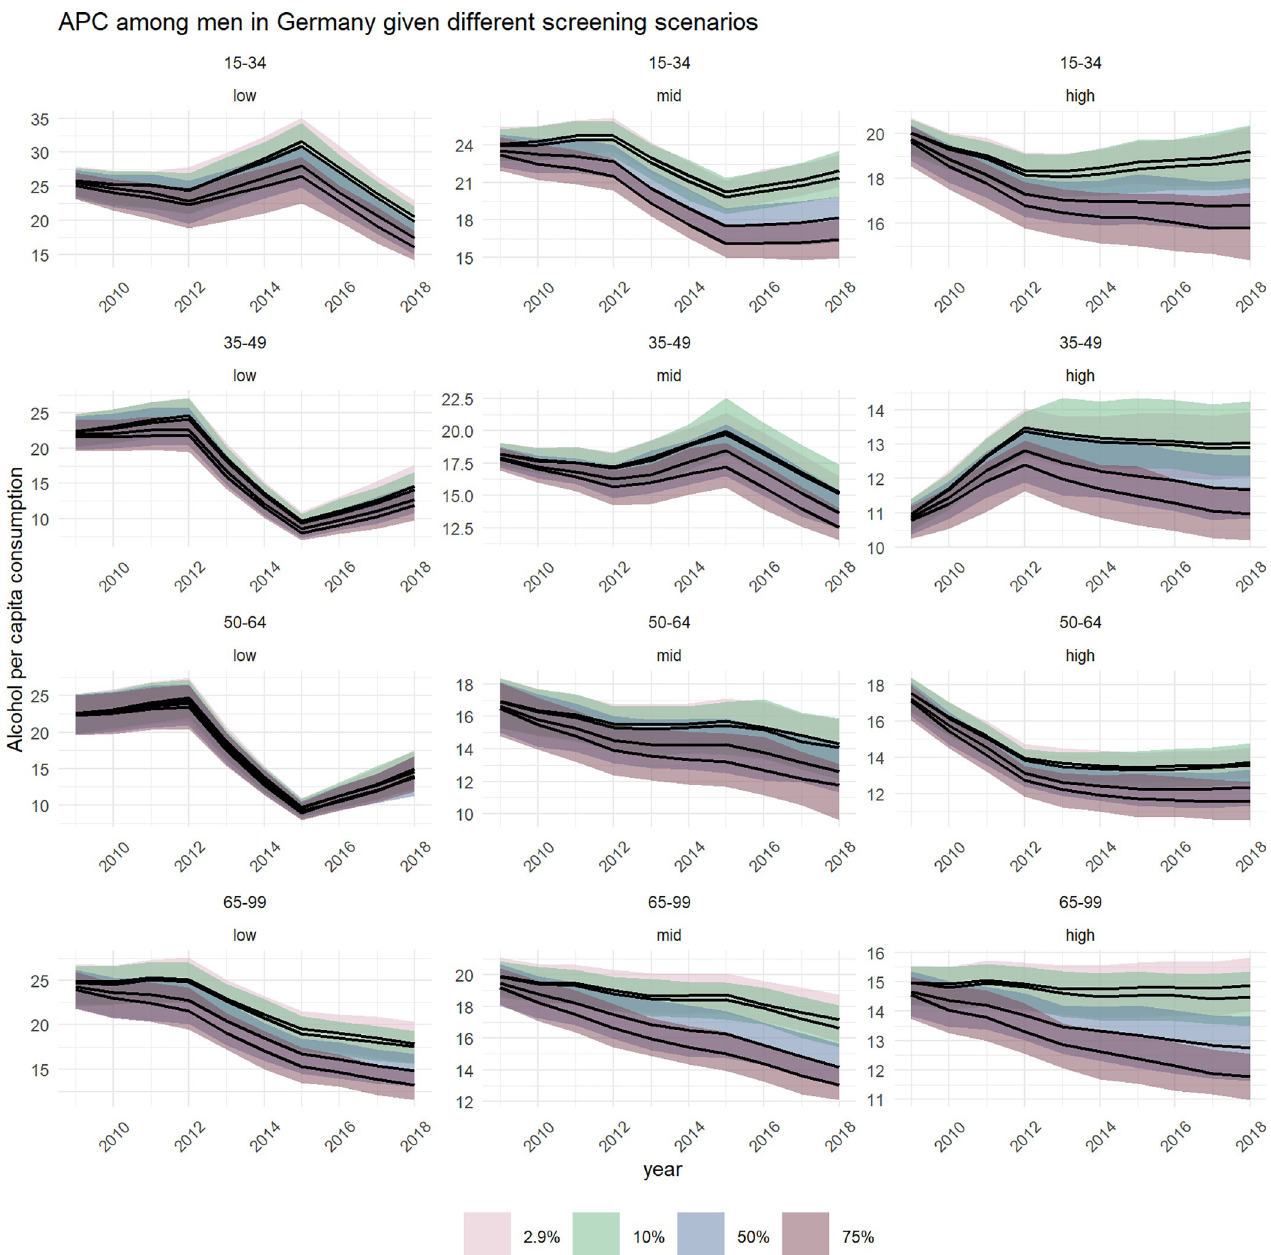
Fig 5. Trends of alcohol per capita consumption (in litres pure alcohol) among German men between 2009 and 2018, stratified by age (horizontal) and education status (vertical), by annual screening coverage (coloured shade). In each facet, the upper line represents the baseline scenario with a screening rate of 2.9%. The increasing coverage rate is represented by all lower lines with the second highest representing 10%, the third highest representing 50%, and the lowest representing 75% screening coverage